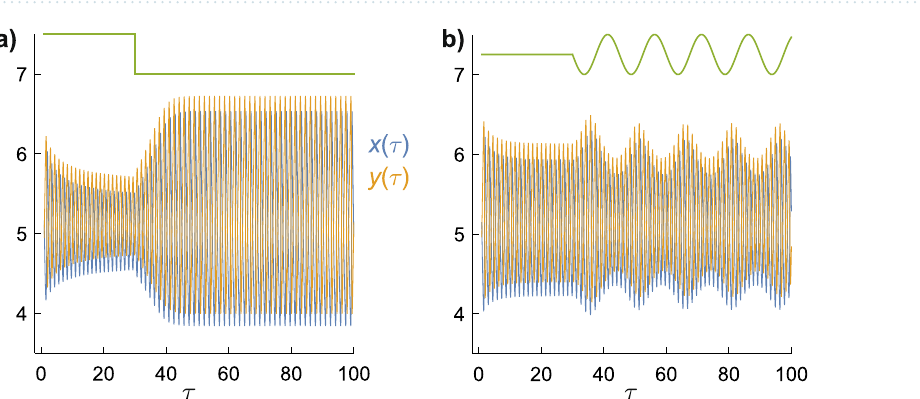
Figure 5. Time-dependence of the concentrations x (τ) and y (τ) when a is noise-modulated. b = 26 for all 3 panels. ( a – c ) Different noise realizations. The green traces at the top indicate the changes in a . The vertical dashed line at τ = 15 marks the time at which the modulation is switched on.